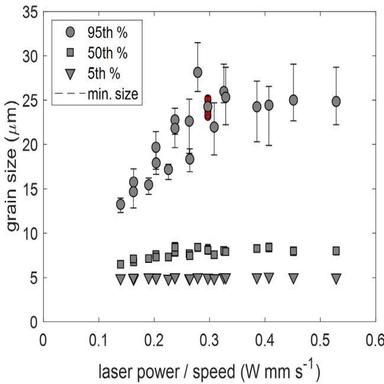
Grain size distribution percentiles (%) for as-built combinatorial sample. The number of grains in the measurements per column ranged from 560 to 1052 with a mean of 758 grains. See for a description of the error bar calculations. Note that the 5th percentile is unreliable because it is very close to the minimum detectable grain size (min. size) of 4.7 lm. Smaller, red data points are the five columns at the default settings.